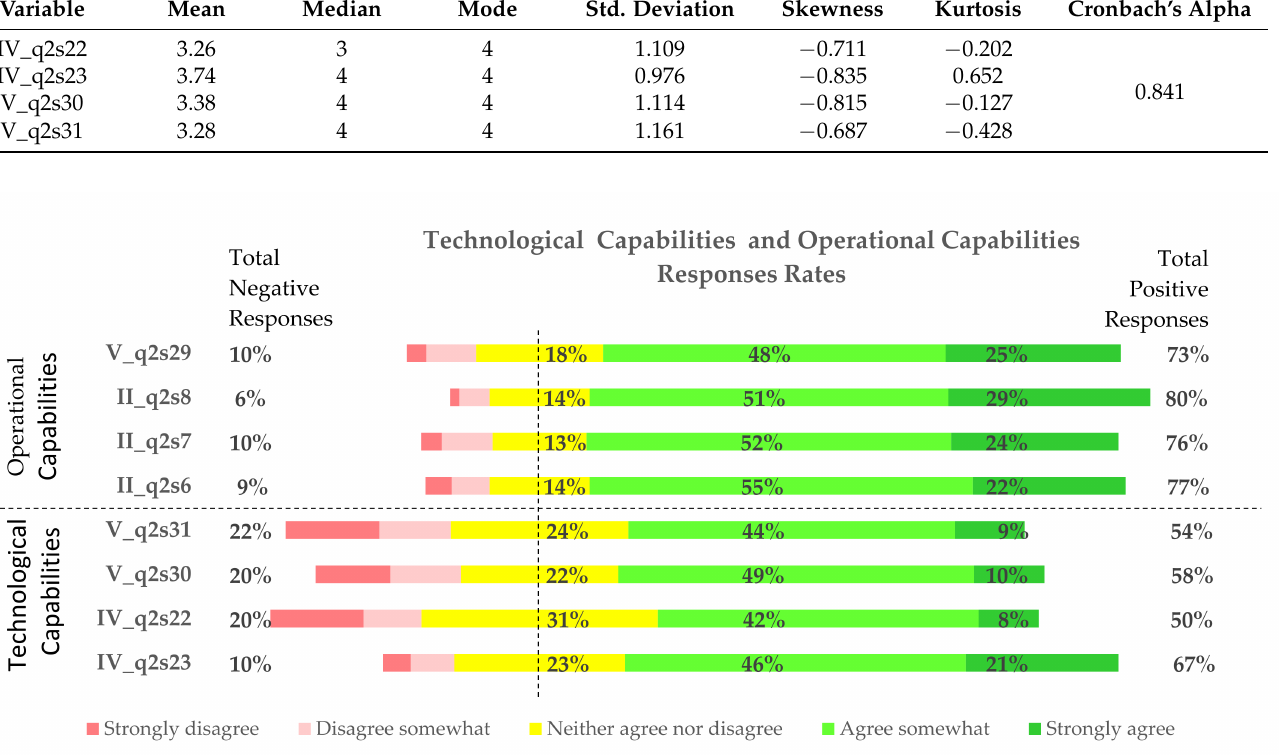
Figure 3. Technological capability and operational capability responses